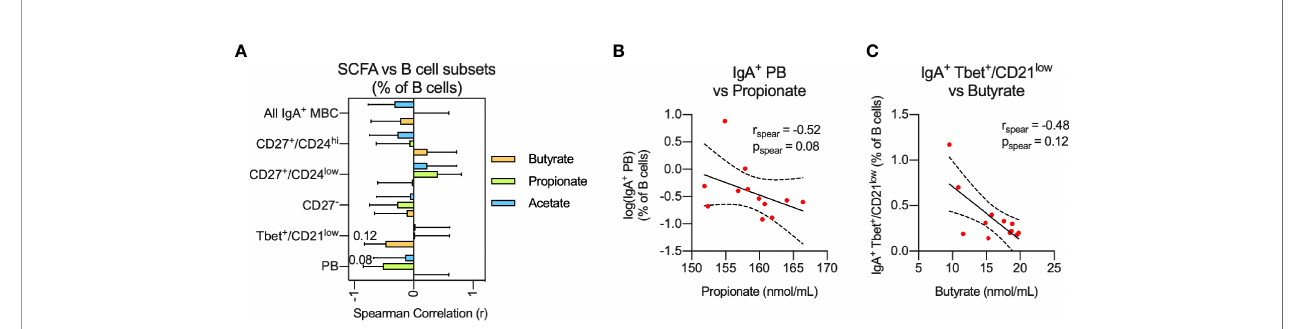
FIGURE 3 | (A, B) Non-parametric correlation between plasma levels of the SCFAs; Butyrate, Propionate and Acetate with abundance of IgA + MBC or IgA + MBC subsets (A) as well as display of raw data for the two strongest correlations (B) identi fi ed in (A) . Correlations are visualized using a linear fi t and 95% CI. Data are displayed as mean correlation ± 95% CI (A) or for each participant (n = 12) in (B) . Signi fi cance of correlation was calculated using Spearman non-parametric test displayed as speci fi c